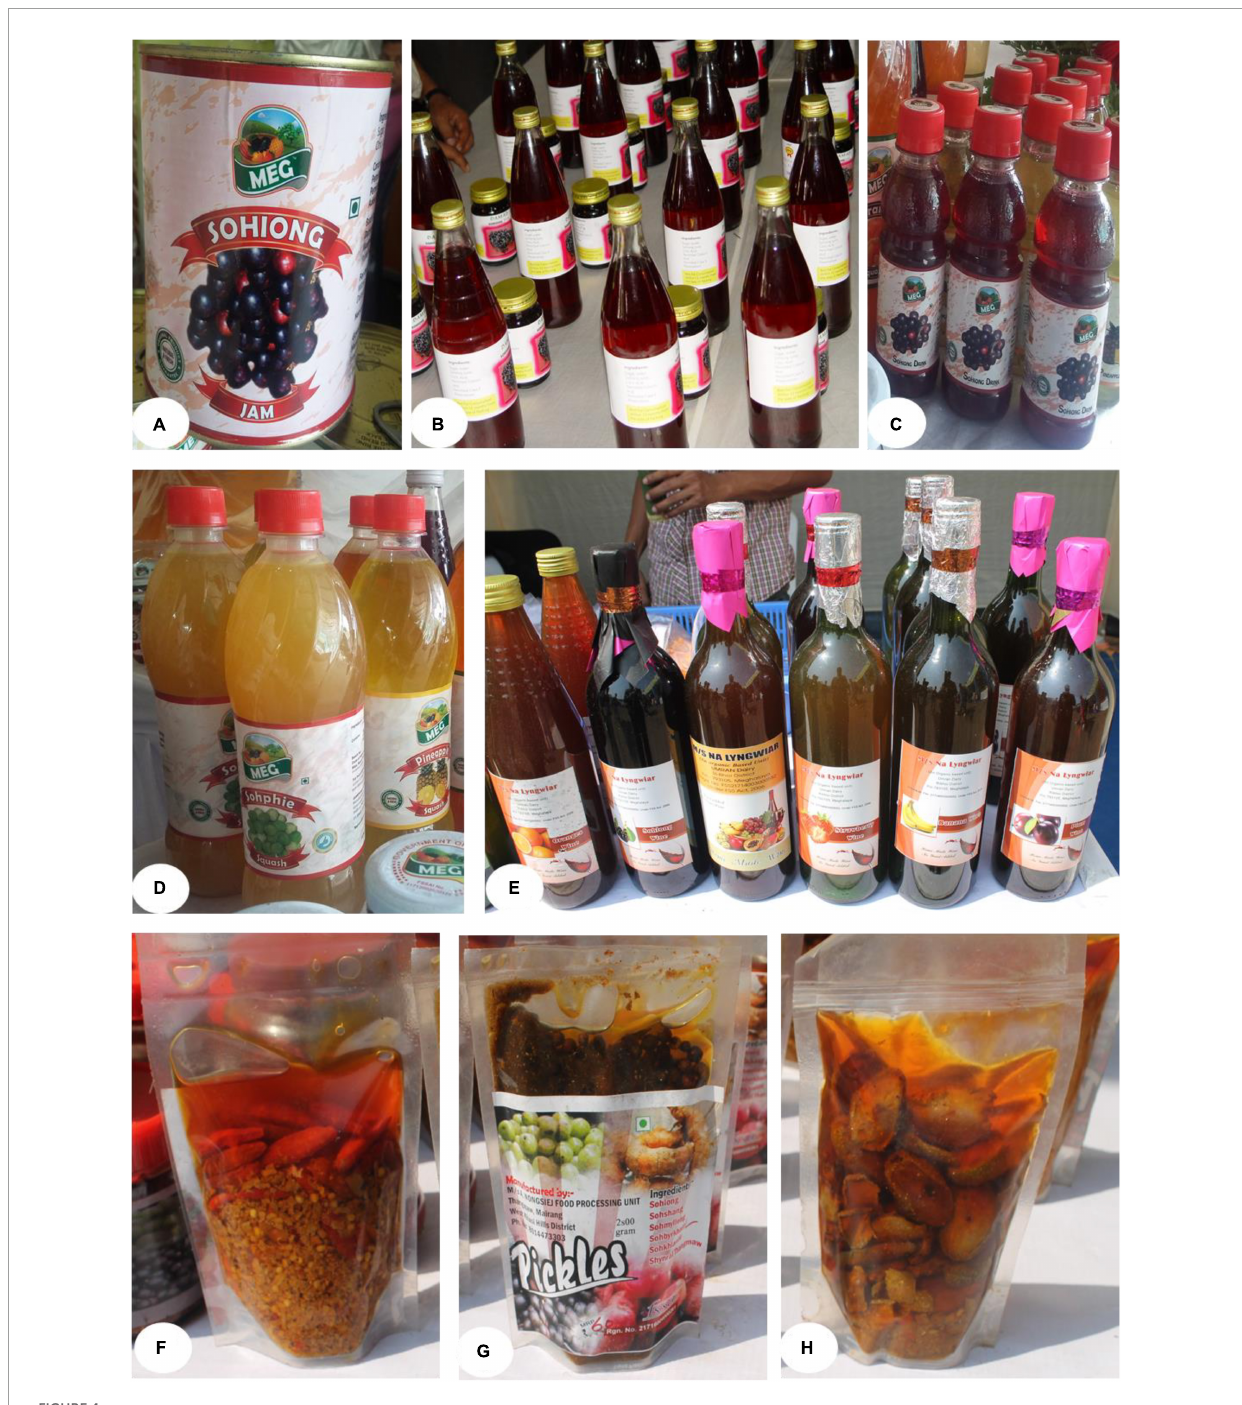
FIGURE4 Different products developed by farmers from wild edible fruits grown in the eastern Himalayas, India. (A) Jam of Sohiong ( P. nepalensis Ser.); (B) Squash of P. nepalensis ; (C) Juice of P. nepalensis ; (D) Juice of Sohphie ( M. esculenta ); (E) Wine of P. nepalensis ; (F) pickle of Sohphoh ( D. indica ); (G) Mixed pickles of P. nepalensis and E. latifolia ; (H) pickle of Sohshang ( E. latifolia